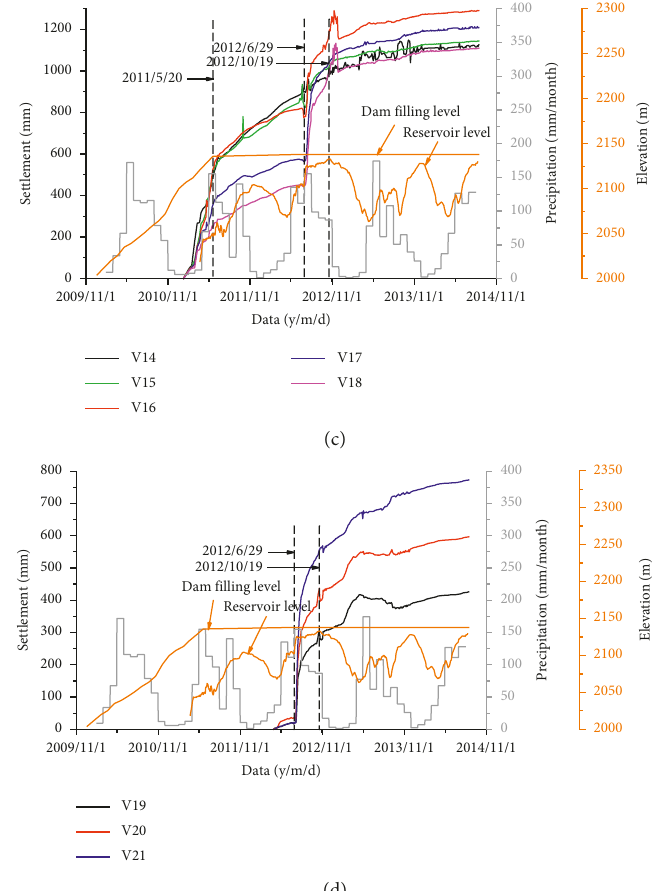
Figure 6: Evolution of settlement values with time in the Maoergai dam. (a) EL. 2031m; (b) EL. 2048m; (c) EL. 2078m; (d) EL.